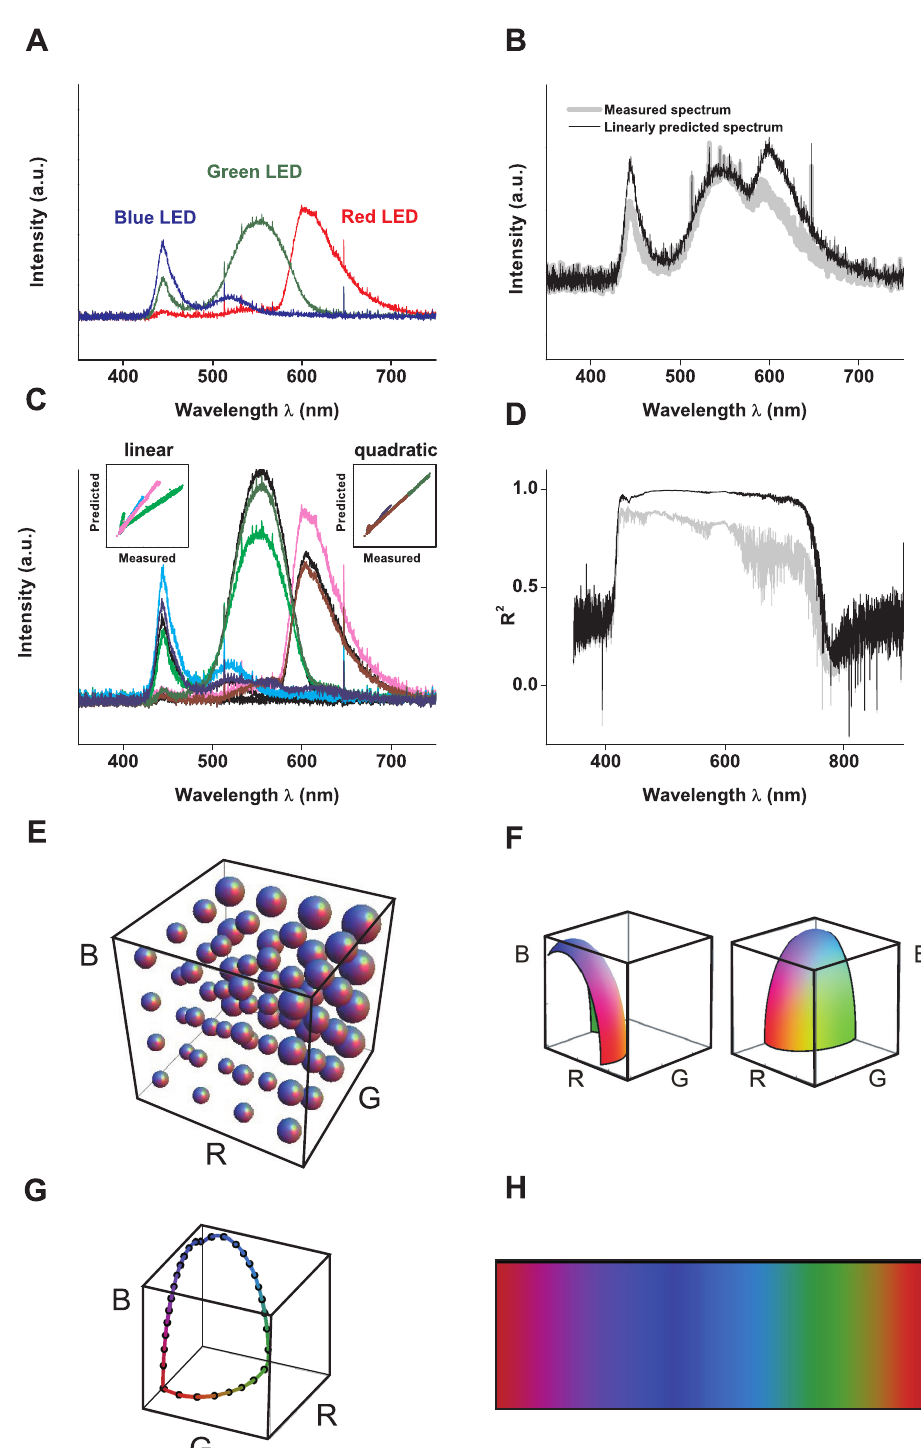
Fig 10. Calibration of the game. A: Spectra of the three LEDs of the computer screen, with coordinates (128, 0, 0) (red), (0, 128, 0) (green) and (0, 0, 128) (blue). B: Measured (gray) and linearly predicted (black) spectra, for a gray screen where RGB = (128, 128, 128). C: Black curves: measured spectra for RGB = (255, 0, 0), (0, 255, 0) and (0, 0, 255). Light colors (pink, light green and cyan): spectra predicted with the linear model. Dark colors (red, green, blue): predictions for the quadratic model. Inset: comparison between predicted and measured intensities for the